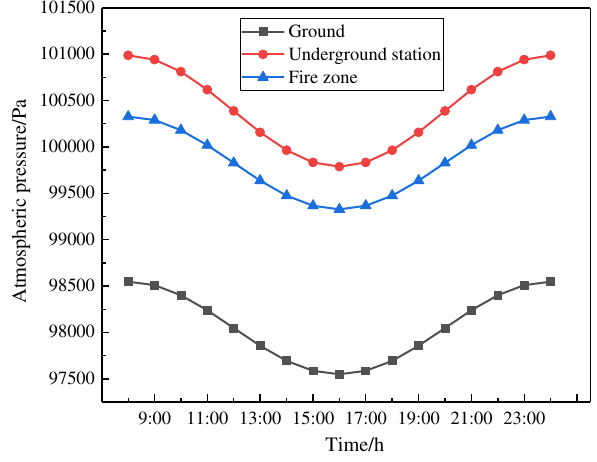
Fig. 2 Analysis on pressure cycle changes of three different mon- itoring points in a